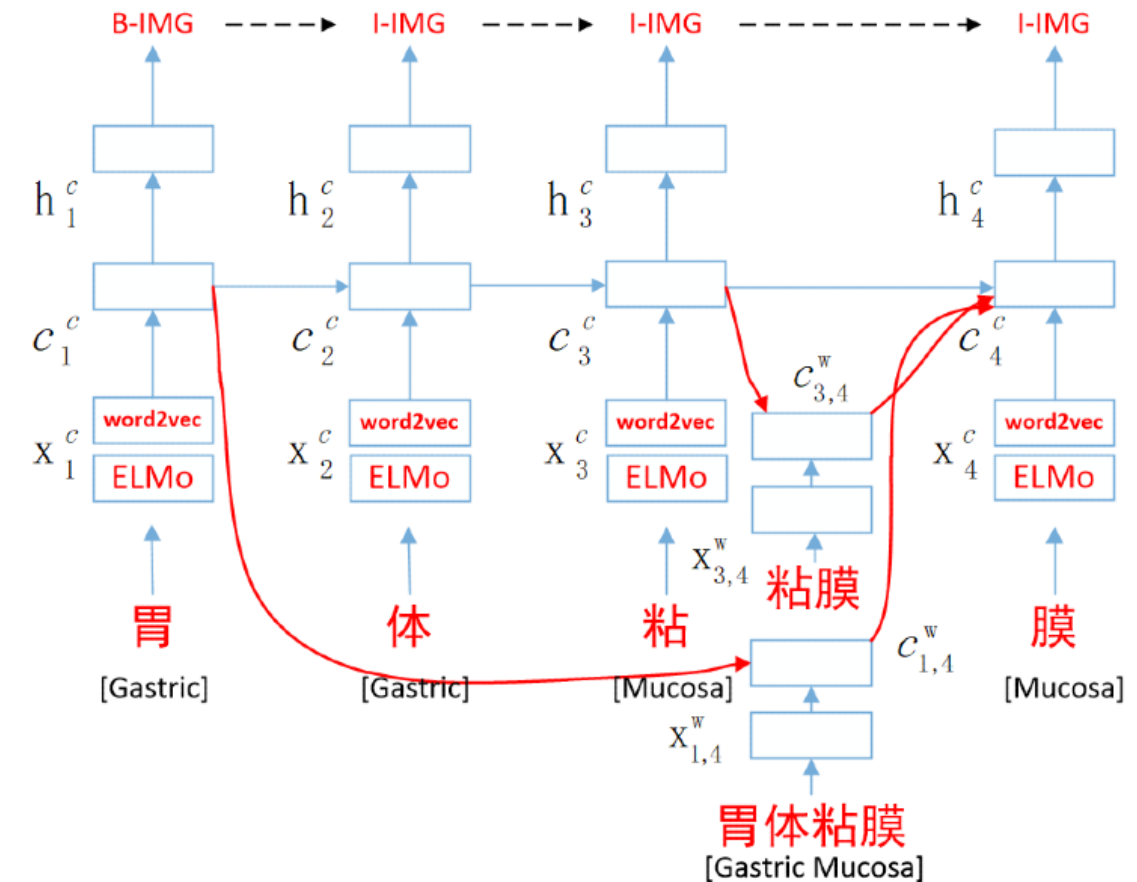
Figure 1. Architecture of the ELMo-lattice-LSTM-CRF model. B-IMG: beginning of image entity; c: cell memory; CRF: conditional random